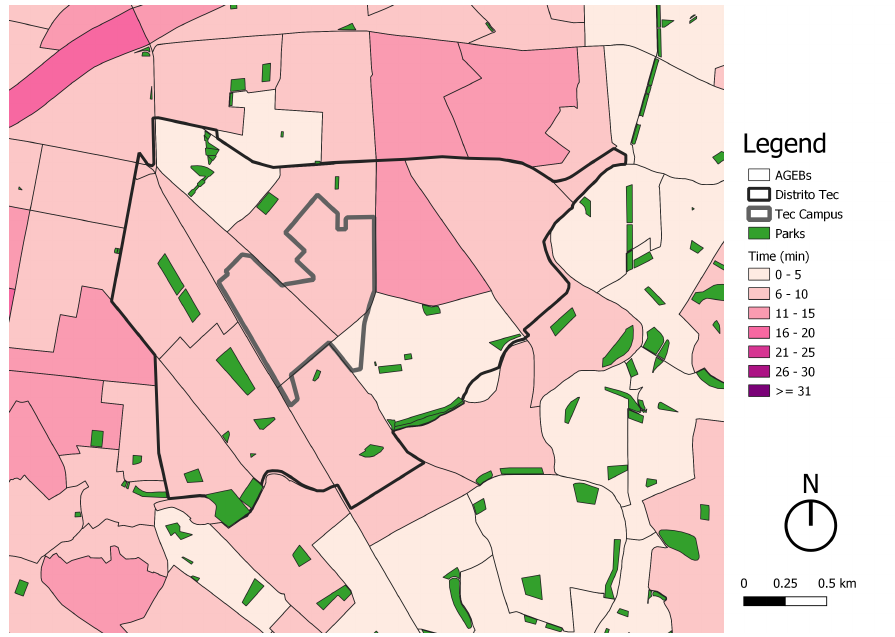
Figure 19. Distrito Tec average travel time to the closest park by